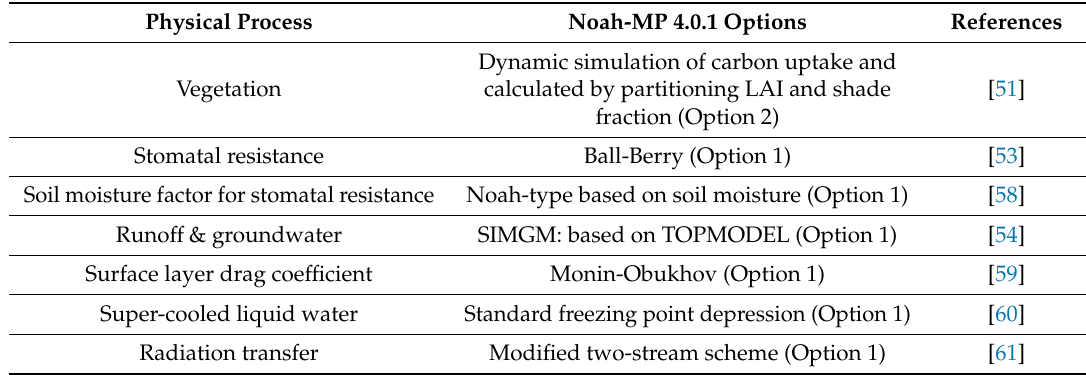
Table 1. Noah-MP options adopted in this study to represent physical